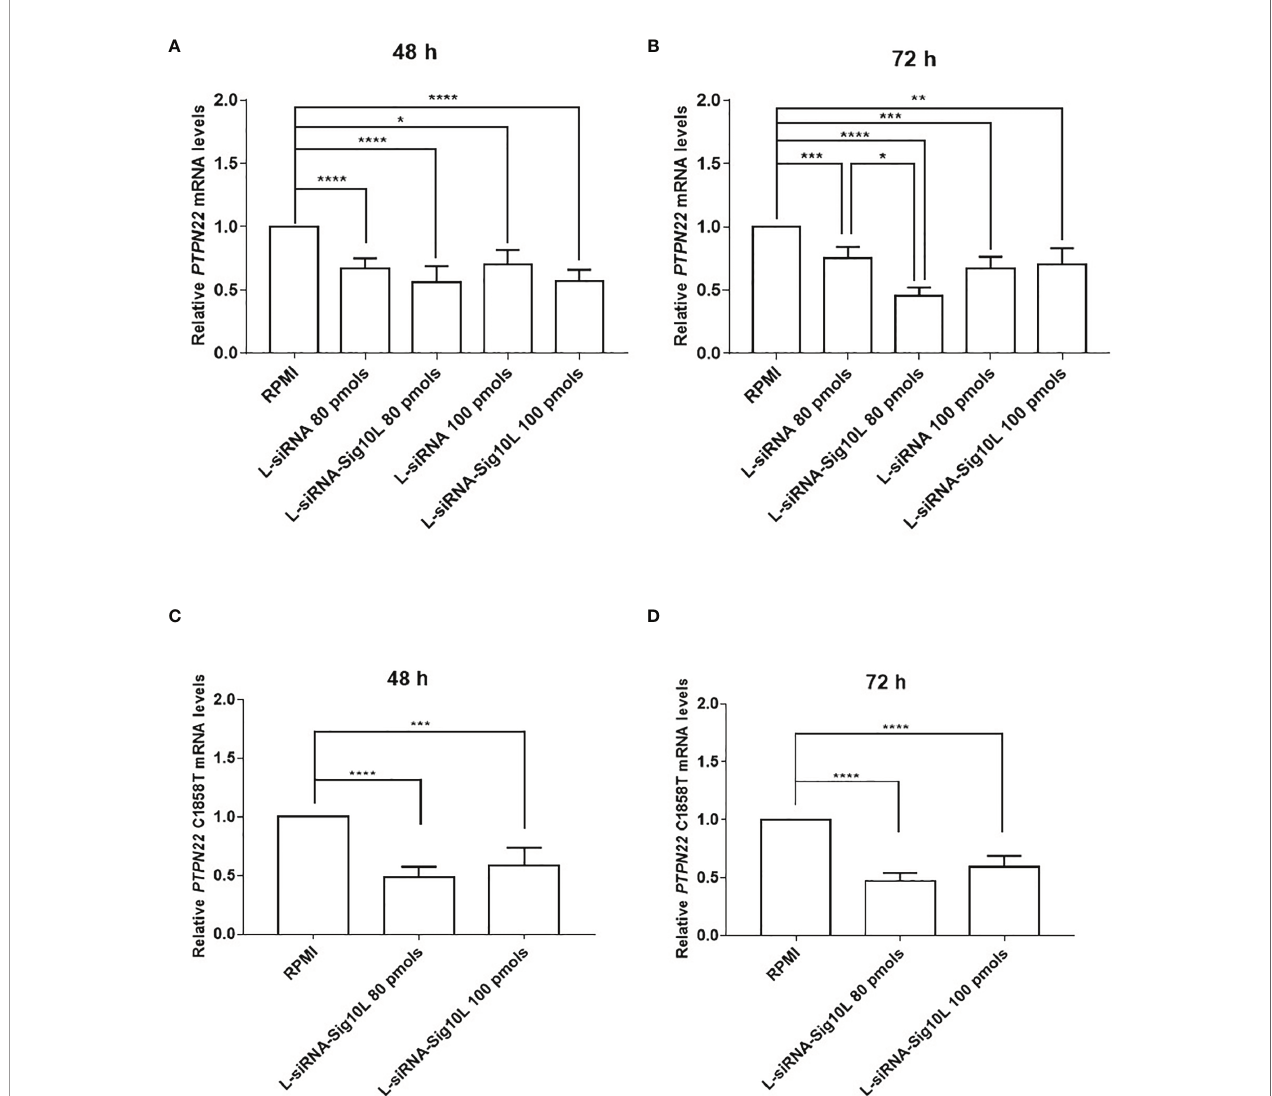
FIGURE 5 | Assessment of LiposiRNA and LiposiRNA-Sig10L ef fi cacy on target PTPN22 and C1858T PTPN22 mRNA. Decrease of target PTPN22 mRNA in HET T1D PBMC analyzed by rtq-PCR upon 48 h (A) and 72 h (B) of lipoplexes treatment. Rtq-PCR analysis of mRNA from HET T1D PBMC treated with lipoplexes at the indicated doses for 48 h (C) and 72 h (D) using a set of speci fi c primers to recognize C1858T PTPN22 mRNA. Values correspond to mean frequency ± SEM of n = 13 (A, B) and n = 12 (C, D) . *p < 0.05, **p < 0.01, ***p < 0.001, ****p <